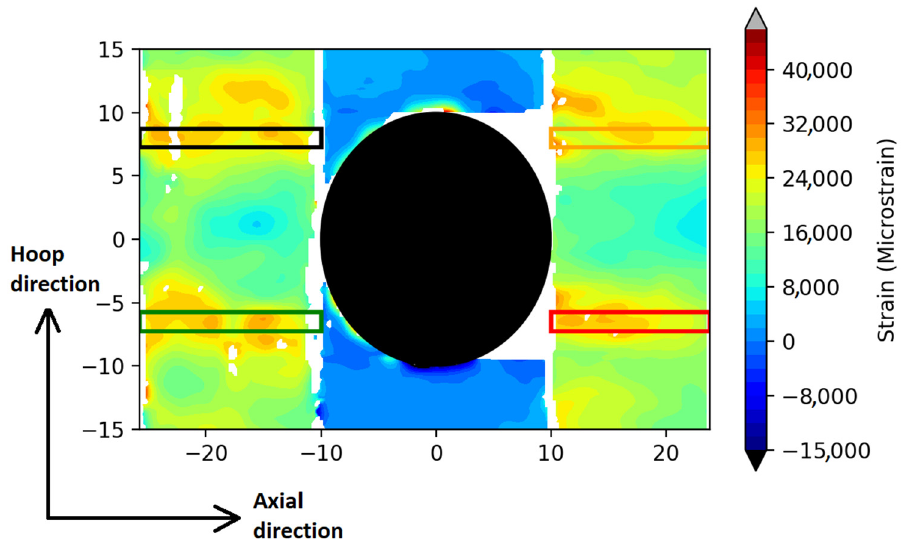
Figure 17. Hoop strain contour plot around the hole at cycle 127,768, shortly before catastrophic failure. The four rectangles highlight the four strain concentrations around the hole.